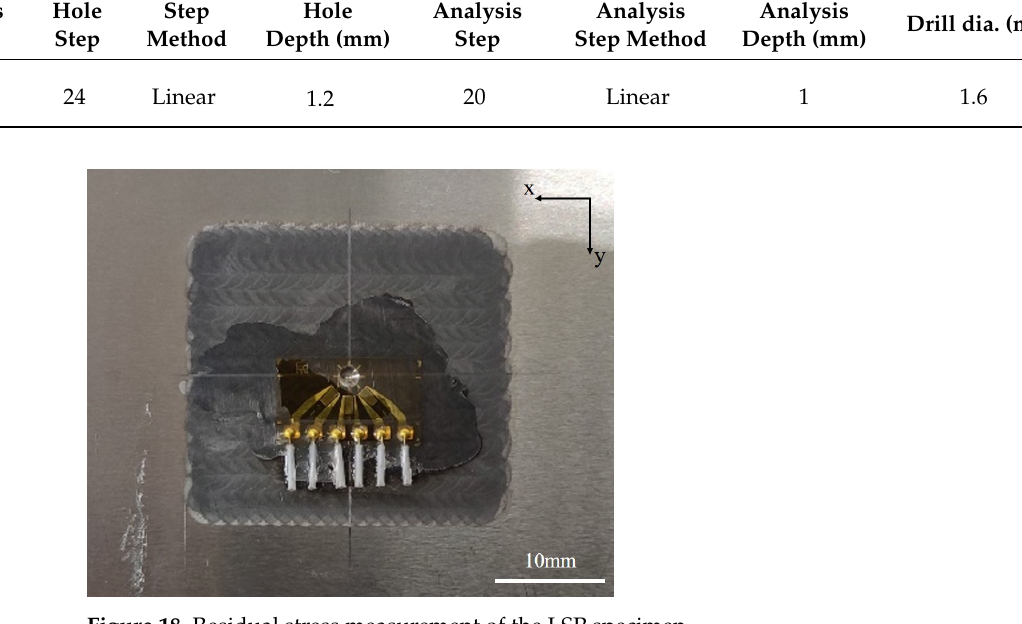
Figure 18. Residual stress measurement of the LSP